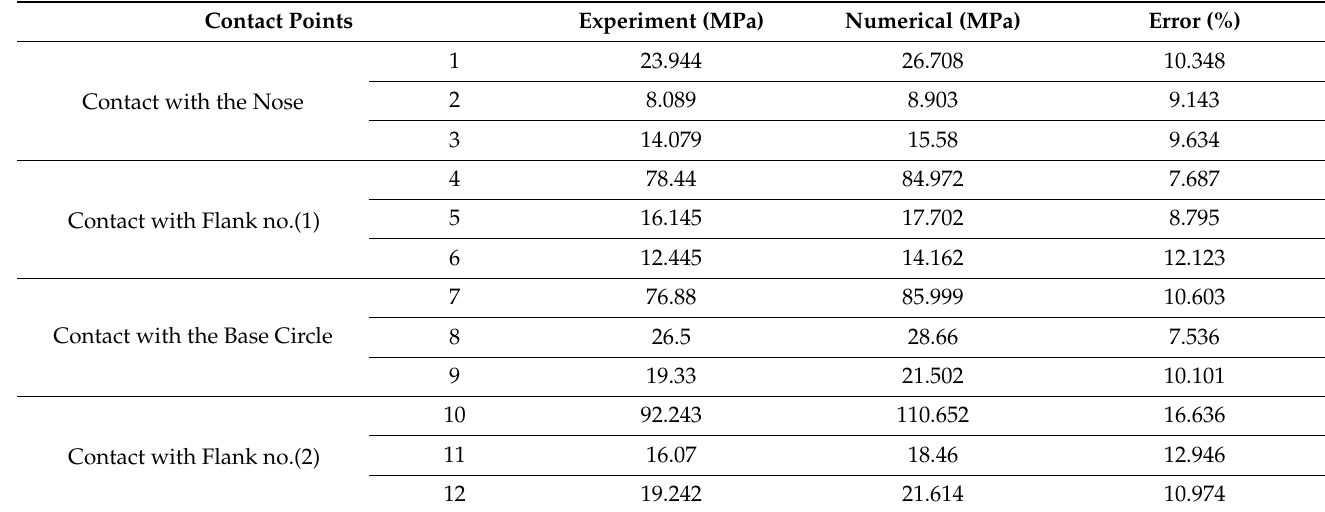
Table 1. Comparison of contact stress at different contact locations for cam profile